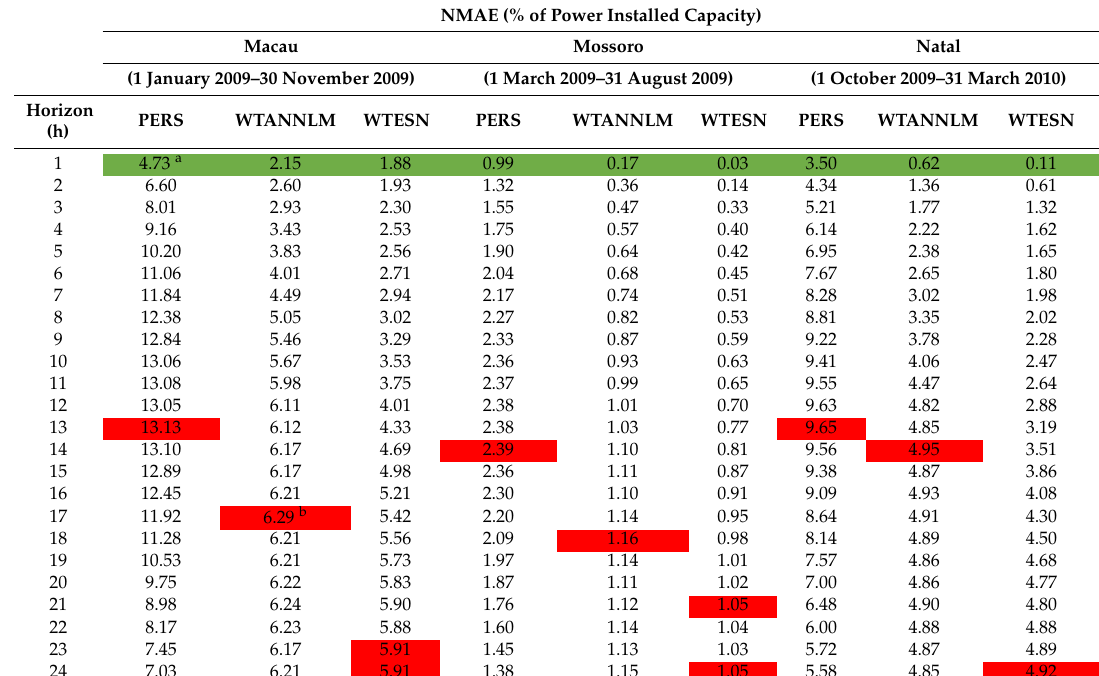
Figure 17. NMAE of wind power forecasts for Macau. Table 4. NMAE of power generation